Question: Does the plotted quantity increase or decrease?
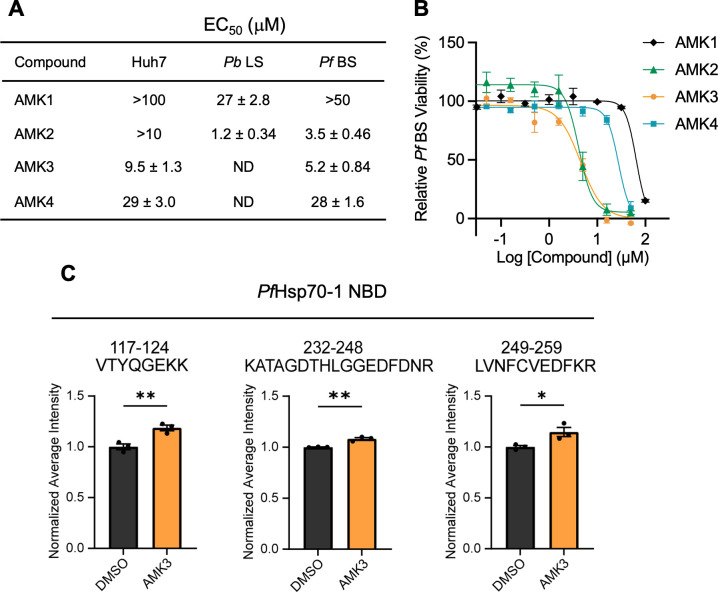
Answer: increasing